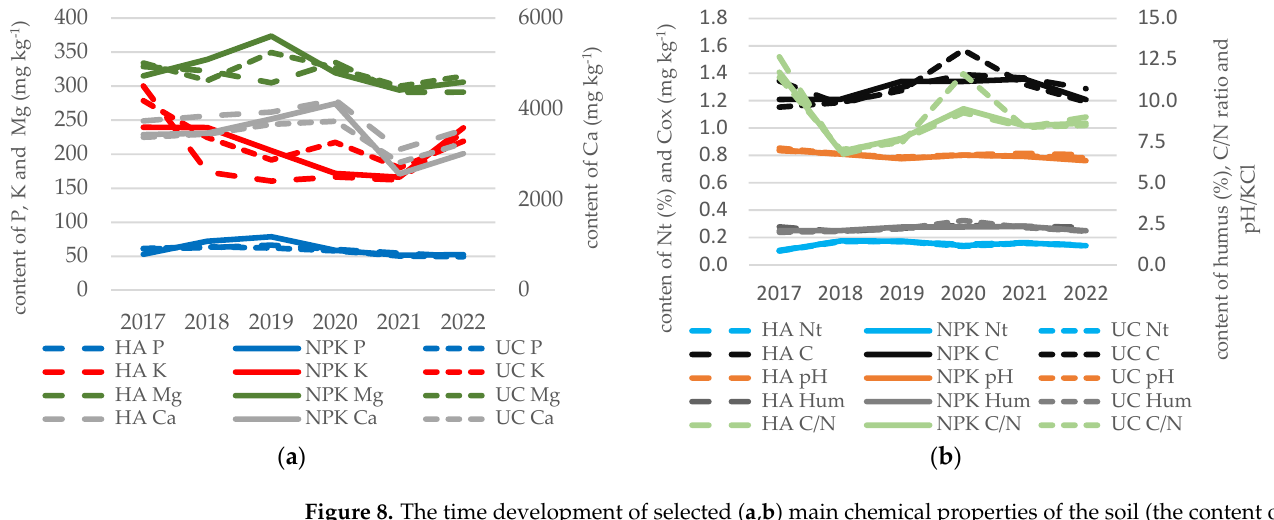
Figure 8. The time development of selected ( a , b ) main chemical properties of the soil (the content of Nt, P, K, Ca, Mg, C-ox, and Humus, and pH/KCl and C/N ratio, according to treatment (HA, NPK, and UC). and Table 8. The changing status ( fi nal minus initial state, 2022 vs. 2017) of the content of nutrients in the topsoil (0–30 cm).